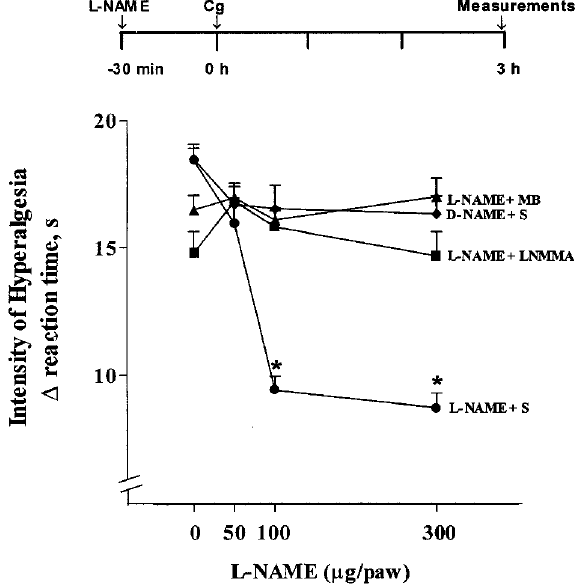
FIG. 2. Antinociceptive effect of intraplantar administration of L-NAME but not of D-NAME on carrageenin-induced hyperalgesia and the blockade of antinociception by local L-NMMA and methylene blue (MB) co-administration. L-NMMA (100 m g/paw), MB (500 m g/paw) or saline (S) were injected 30min before carrageenin (Cg, 100 m g/paw). L-NAME or D-NAME (50–300 m g/paw) were also injected 30min before Cg, and the intensity of hyperalgesia was measured 3h after the hyperalgesic stimulus (see injections diagram). The symbols are the mean + SEM of five rats/ group. *indicates significant differences ( P < 0.01) in compar- ison with the control (saline, O) or treatment with L-NAME, MB, D-NAME.